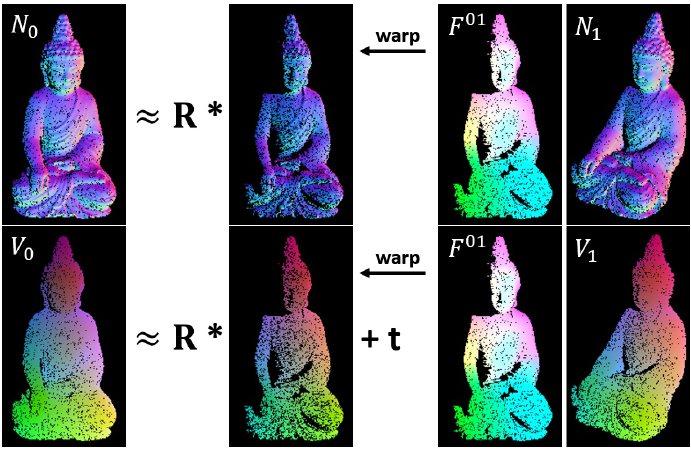
Figure 7. Normal maps and vertex maps that have been warped by optical flow F 01 . Assuming rigid scenes, normals should be identical up to a rotation, vertices up to a rotation and a